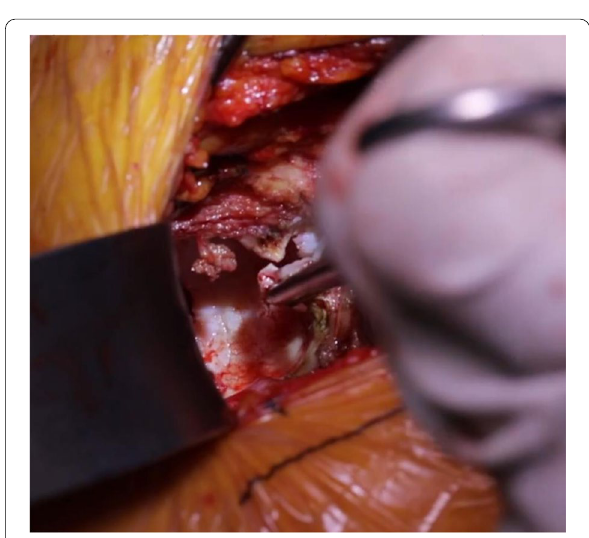
Fig. 5 Superior capsulectomy and